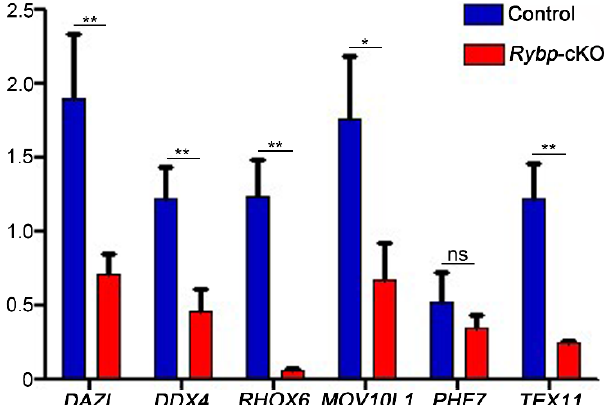
Figure 5. Expression of meiosis-related genes decreased in germ-cell-specific Rybp -knockout mice. Relative mRNA expression of meiosis-related genes in male control and Rybp -cKO mice. Data were analyzed using mean ± SEM for three mice per group. * indicates significant difference of p < 0.05. ** indicates extremely significant difference of p < 0.01. ns indicates no difference.